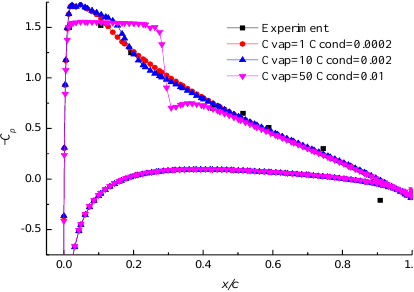
Figure 8. Comparison with different coefficients [26] .